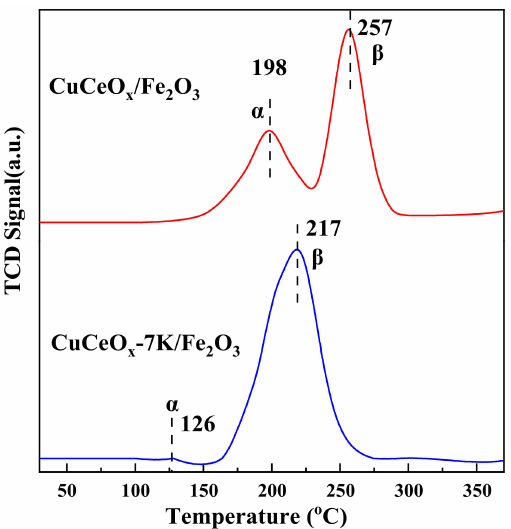
Figure 7. H 2 -TPR spectrum of CuCeO x -xK/Fe 2 O 3 catalysts.